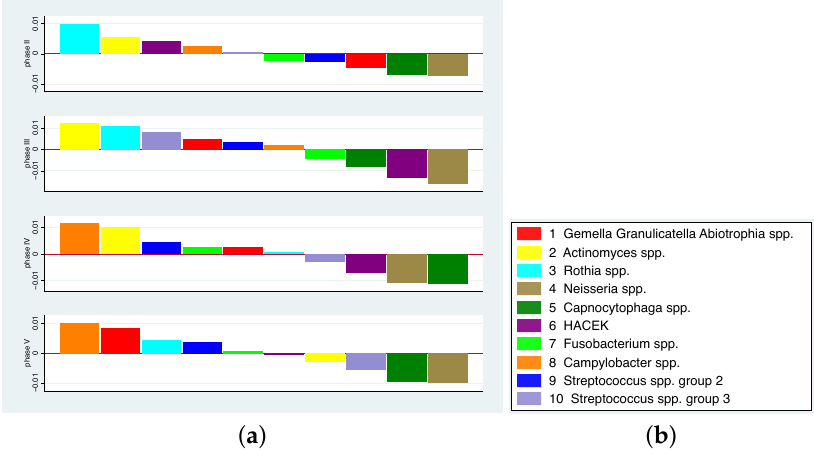
Figure 2. ( a ) Sorted mean values of the average changes for bacteria 1 to 10 for phase II (top) to phase V (bottom). ( b ) Colour scheme for the bacterial groups; spp. = species